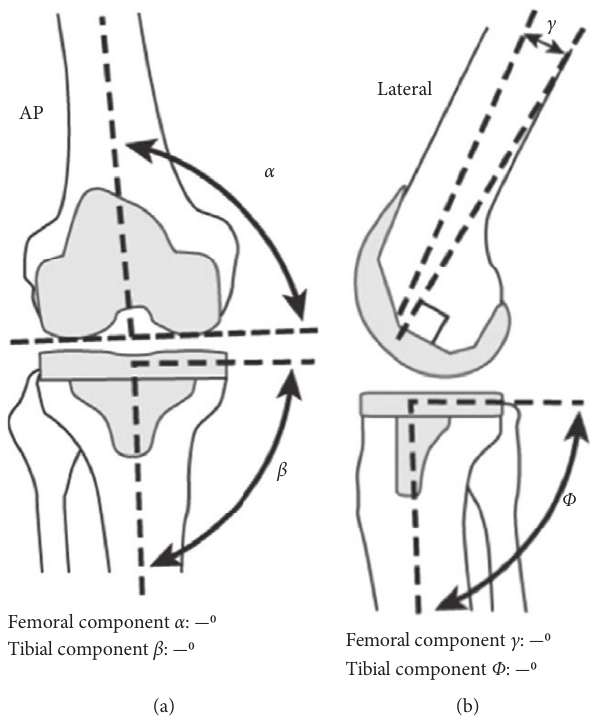
Figure 2: Roentgenographic evaluation parameters after total knee arthroplasty (TKA) (Ewald FC).